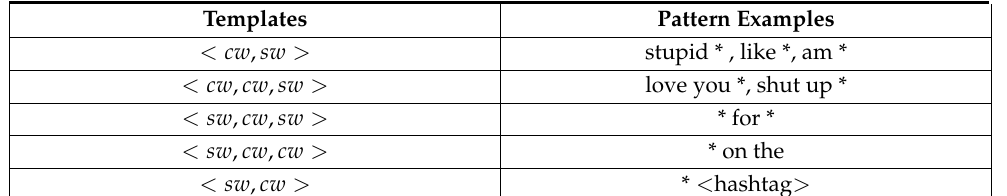
Table 6. Examples of patterns and templates extracted through the basic pattern extraction mecha- nism. The asterisk (*) refers to a wildcard token which can be replaced by other subject words. Templates Pattern Examples < cw , sw > stupid * , like *, am * < cw , cw , sw > love you *, shut up * < sw , cw , sw > * for * < sw , cw , cw > * on the < sw , cw > * < hashtag